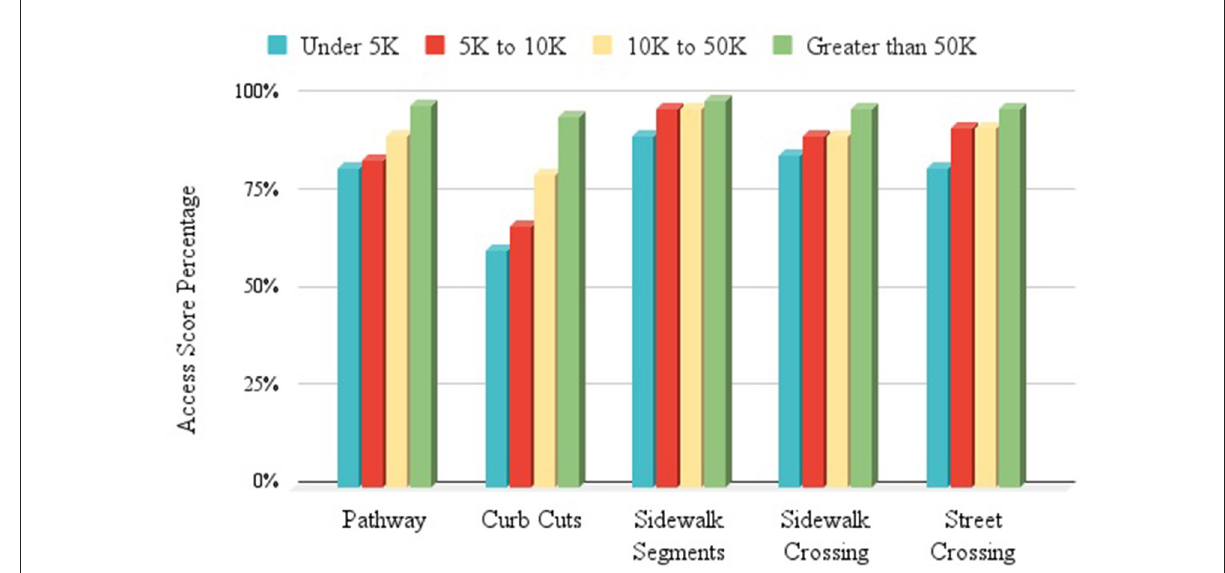
FIGURE5 Access Scores by Community Population Groups—shows access feature scores (Pathway, Curb Cuts, Sidewalk Segments, Sidewalk Crossing, Street Crossing) by community population groups ranging from under 5,000 to > 50,000 people. Communities with populations > 50,000 score highest across all